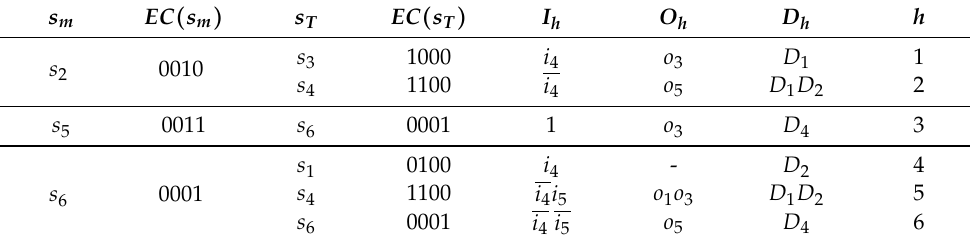
Table 4. Table of BlockS 2.